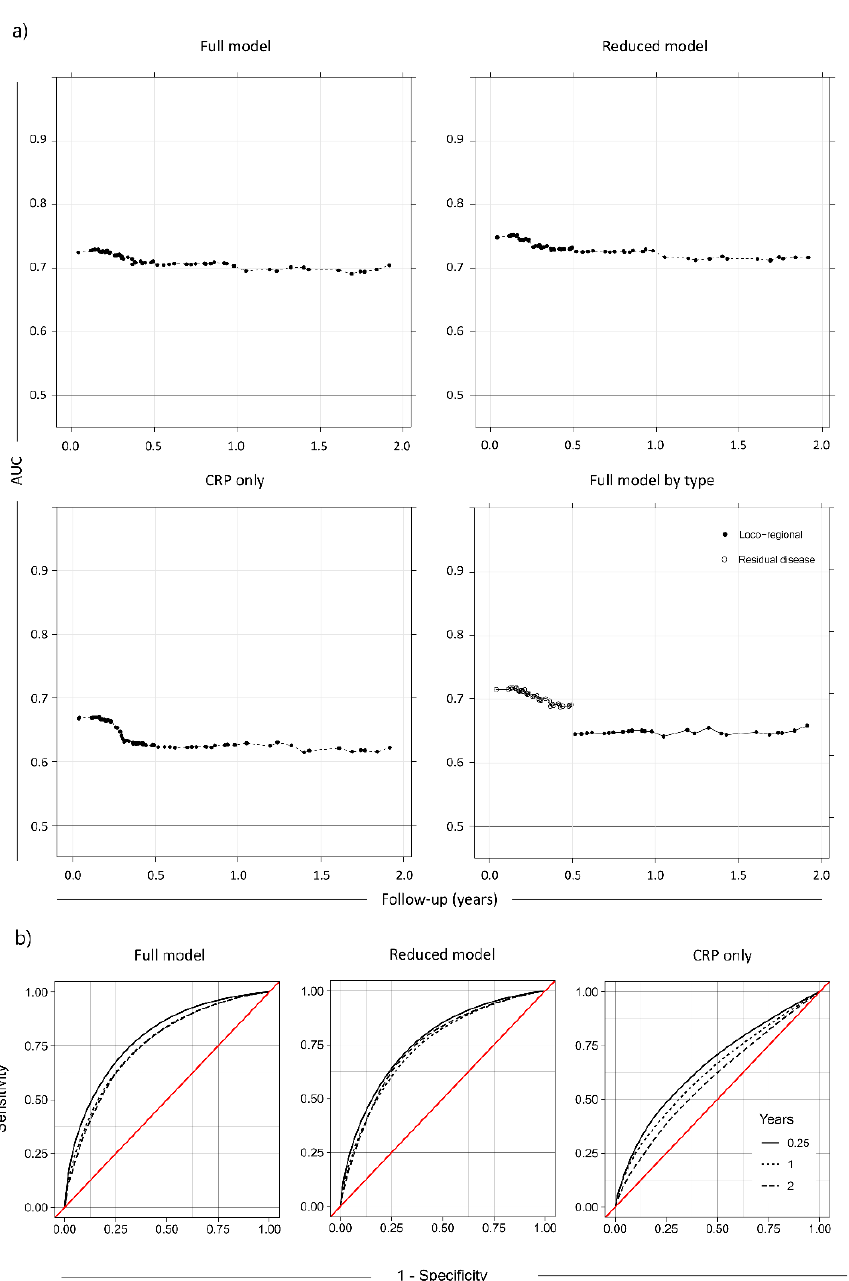
Figure 3. ( a ) Full model: AUC for Cox proportional hazards model over time for all variables. The AUC value (the area under the ROC curve) is an estimate of the predictive power of the model, where high AUC indicates low false positive and/or false negative rates and AUC = 0.5 is random chance. The AUC showed a clear peak at 0 – 6 months. Reduced model: AUC over time for a reduced model only using the significant factors (Trc, CRP, pretreatment BMI, and stage). The AUC was not appreciably different from the full model. CRP only: AUC over time for only CRP. It is evident that CRP alone was a worse predictor than the full model. Full model by type: The full model divided by recurrence type. The model was most predictive of residual disease, followed by loco-regional recurrence and general relapse. ( b ) ROC curves for the models in a). The ROC curves are calculated at 3 months, 1 year and 2 years of follow-up time.